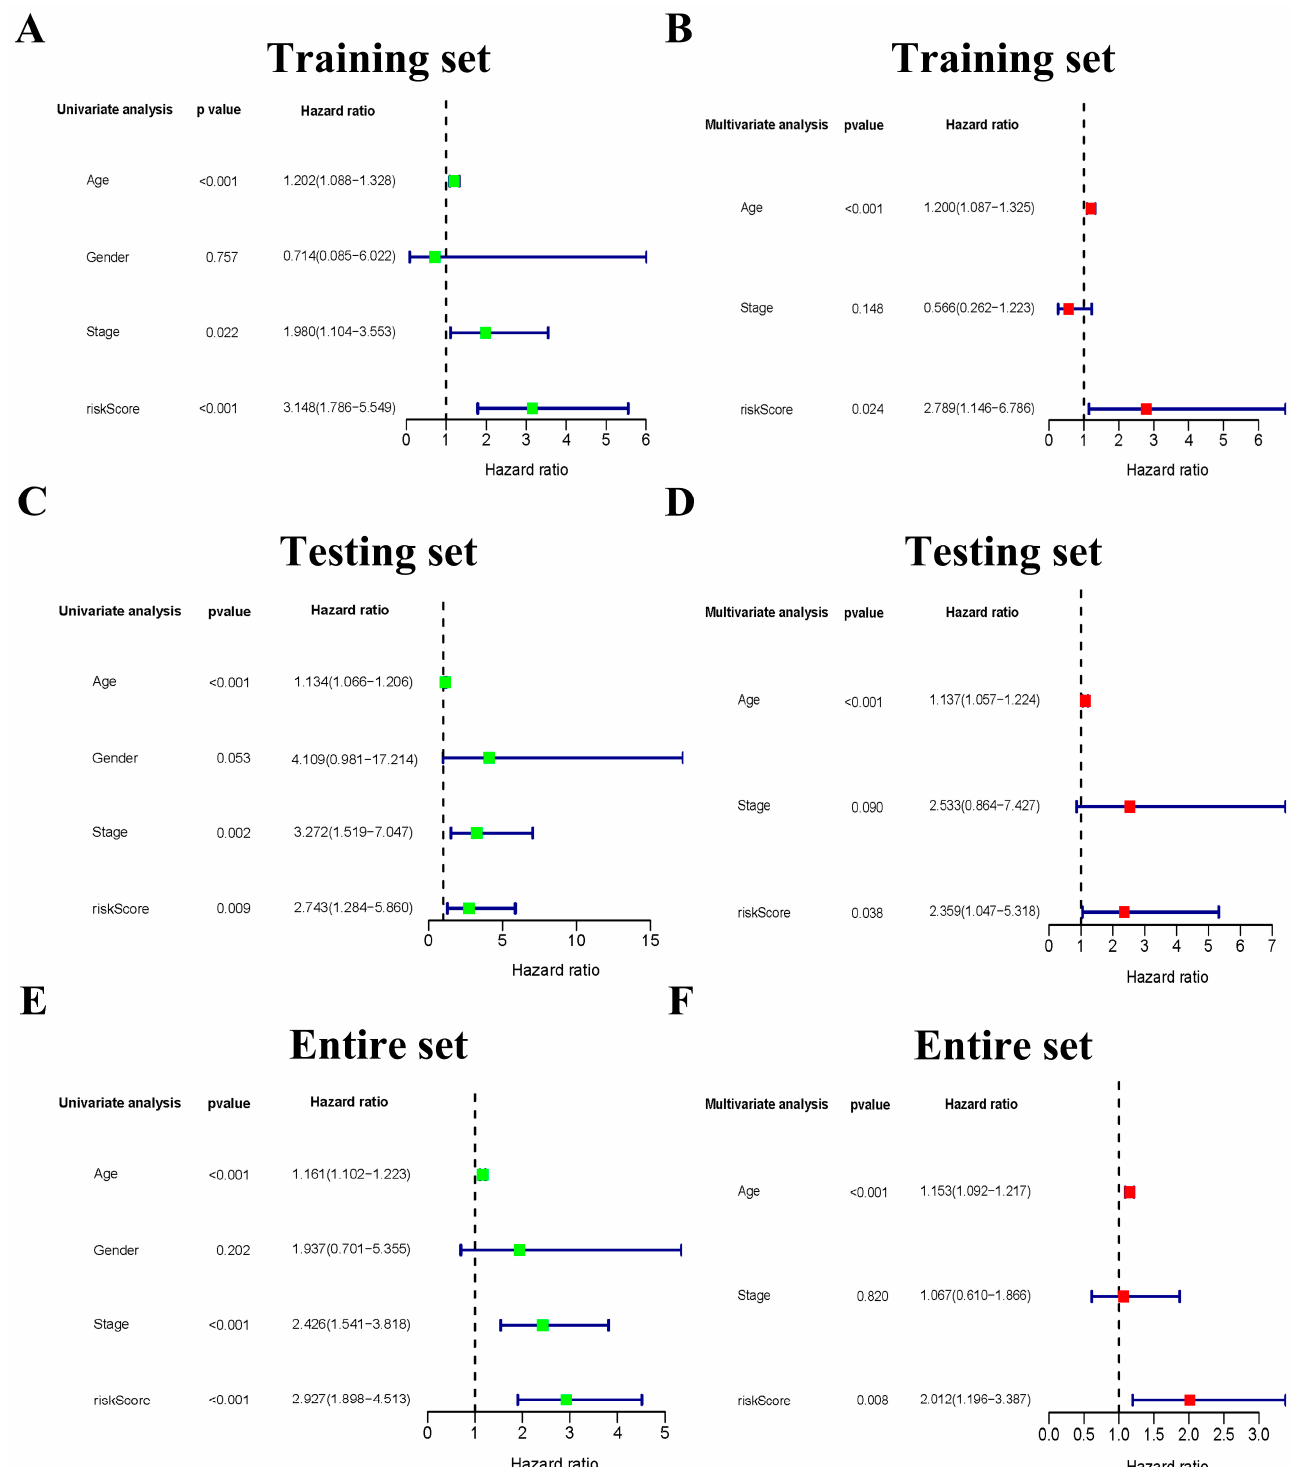
Figure 4. The association between clinicopathological factors and OS in patients with THCA. Uni- variate Cox regression analyses ( A ) and multivariate Cox regression analyses ( B ) of the association between clinicopathological factors and OS in the training set. Univariate Cox regression analyses ( C ) and multivariate Cox regression analyses ( D ) of the association between clinicopathological fac- tors and OS in the testing set. Univariate Cox regression analyses ( E ) and multivariate Cox regression analyses ( F ) of the association between clinicopathological factors and OS in the entire set.